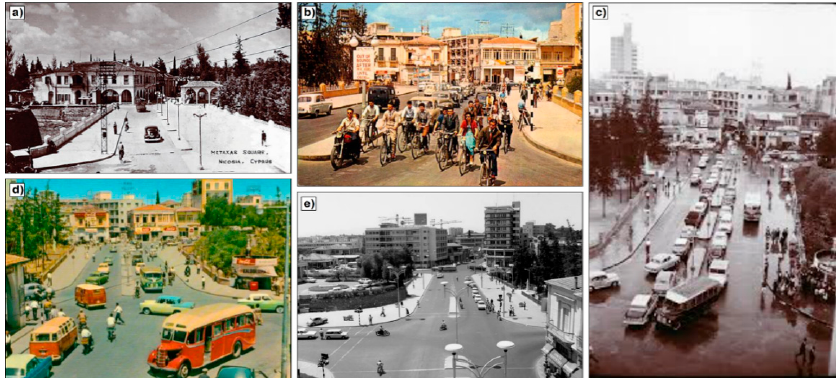
Figure 3. Photographs of Eleftheria Square (Metaxa Square) in 1945 (Photo captured by J. Arthur Dixon) ( a , b ), 1957 (Photo captured by Felix Giaxis) ( c ), 1950 ( d ) and 1969 ( e ).